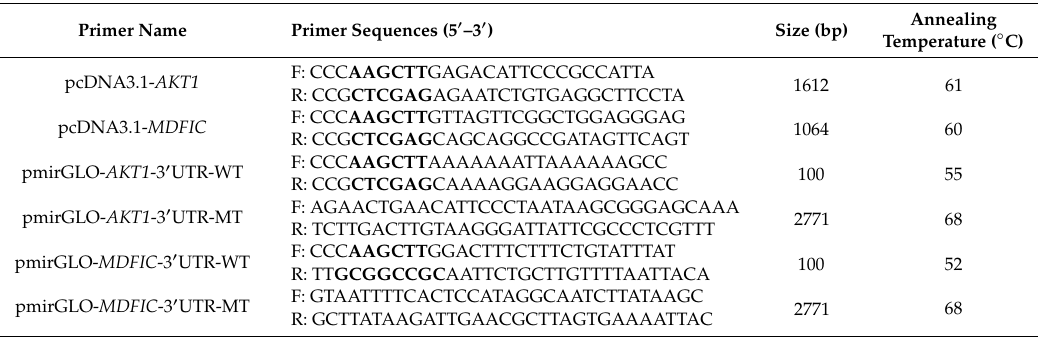
Table 3. Primers used for plasmids